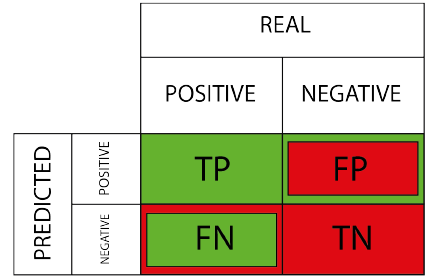
Figure 6. Outputs of the classification model.